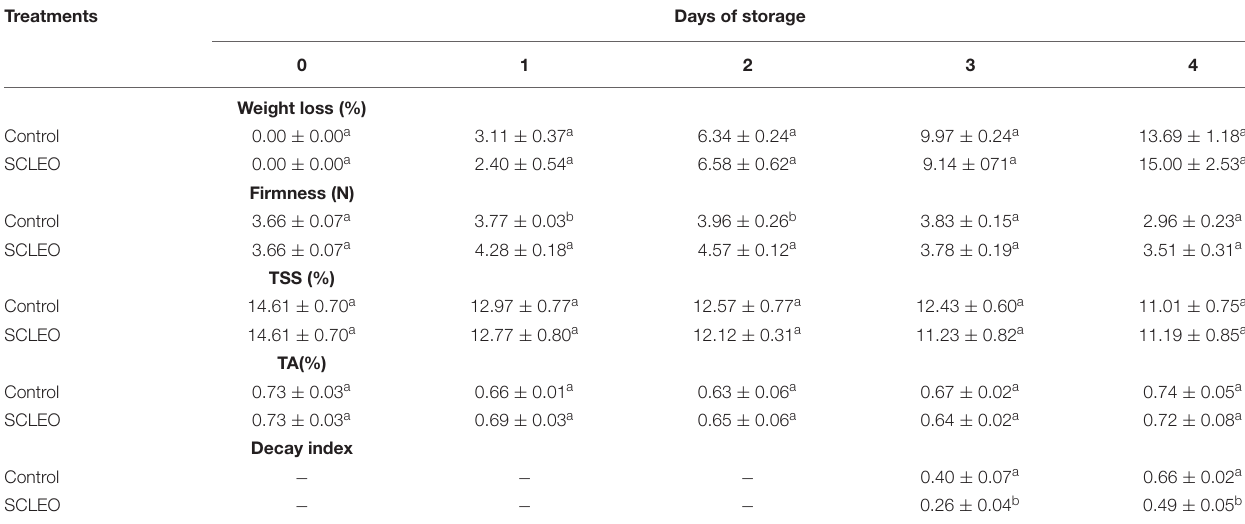
FIGURE 3 | Images obtained by fluorescence microscopy ( × 400) for B. cinerea treated with SCLEO. First row: bright field. Second row: propidium iodide (PI). (a) Control, (b) hyphae treated with SCLEO. TABLE 1 | Effects of SCLEO vapor treatment on the quality of fresh strawberries during storage. Treatments Days of